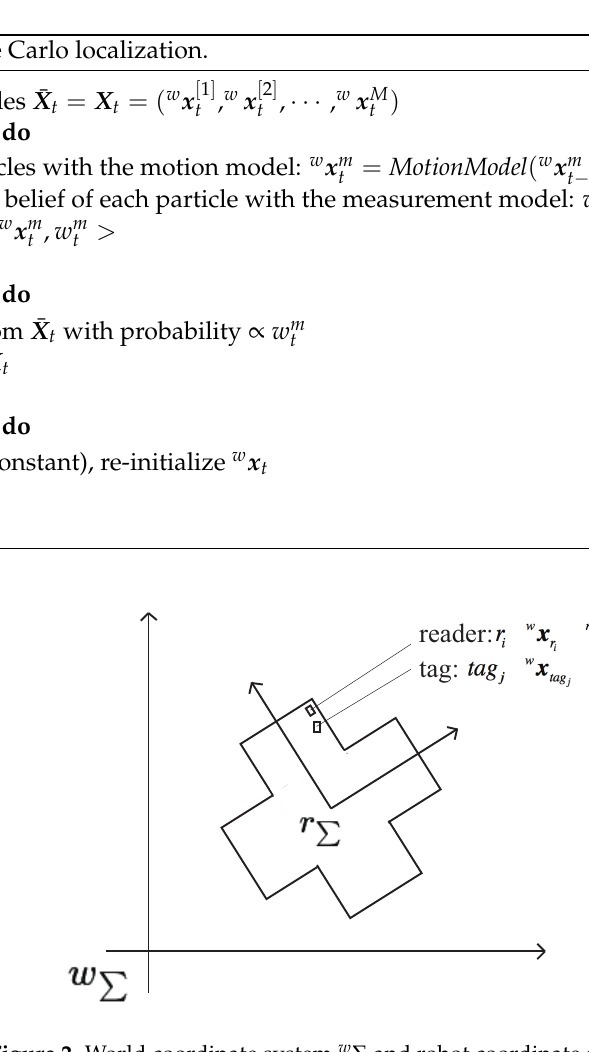
Figure 2. World coordinate system w Σ and robot coordinate system r Σ